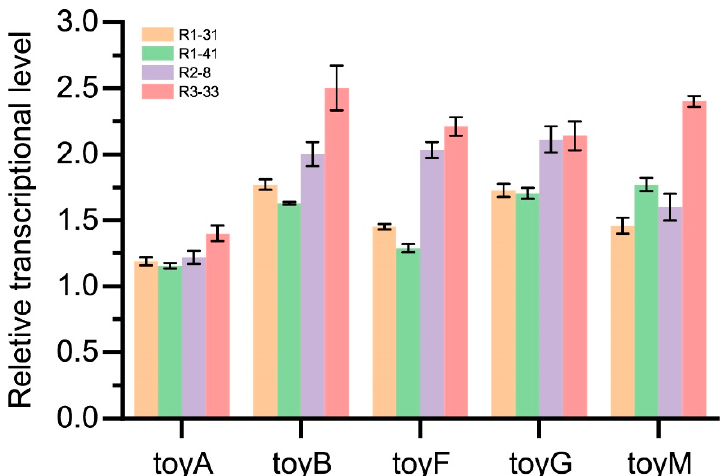
Figure 3. Relative expression levels of pathway-specific regulator gene toyA , and structural genes toyB , toyF , toyG , and toyM in R1-31, R1-41, R2-8 and R3-33. The mRNA was extracted from strains grown in GYM medium for 72